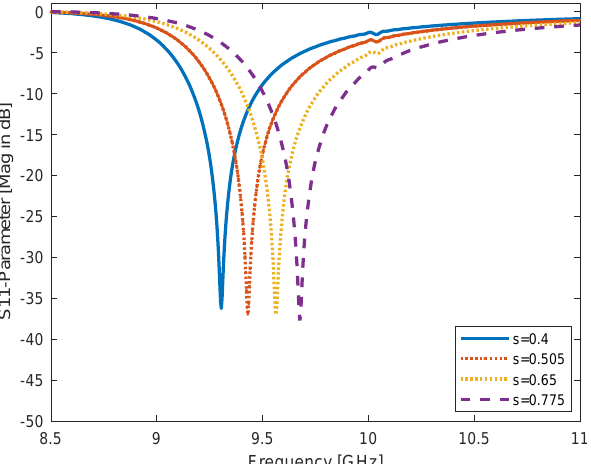
Figure 6. Alteration of horizontal shift between two CSRR rings (upper and lower loops) sh-parameter for sh = 0.14, 0.22, 0.32, 0.4, and 0.5 mm; resonant frequency is shifted to the left once the sh parameter is increased.